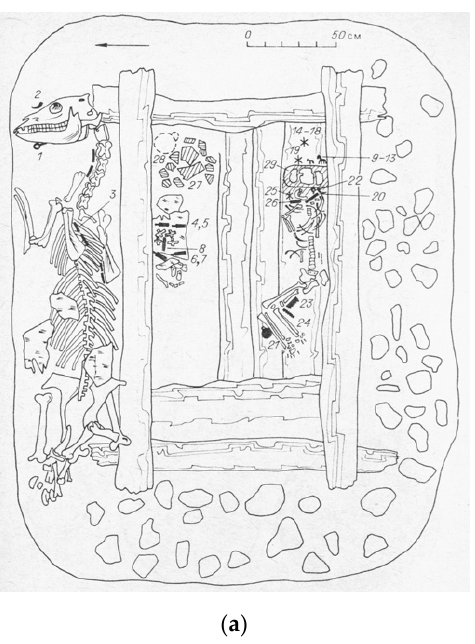
Figure 5. Contents of kurgan 22, Yustyd XII. (Adapted from Kubarev 1991, PL LI). Kubarev identifies 4 as a volumetric undefined animal figure with plug-in leather tail (he does not distinguish the animal as either deer or horse) and identifies 5–8 as remnants of figures of horses and deer, without specifying which is which. Plan of burial is Figure 3 above.